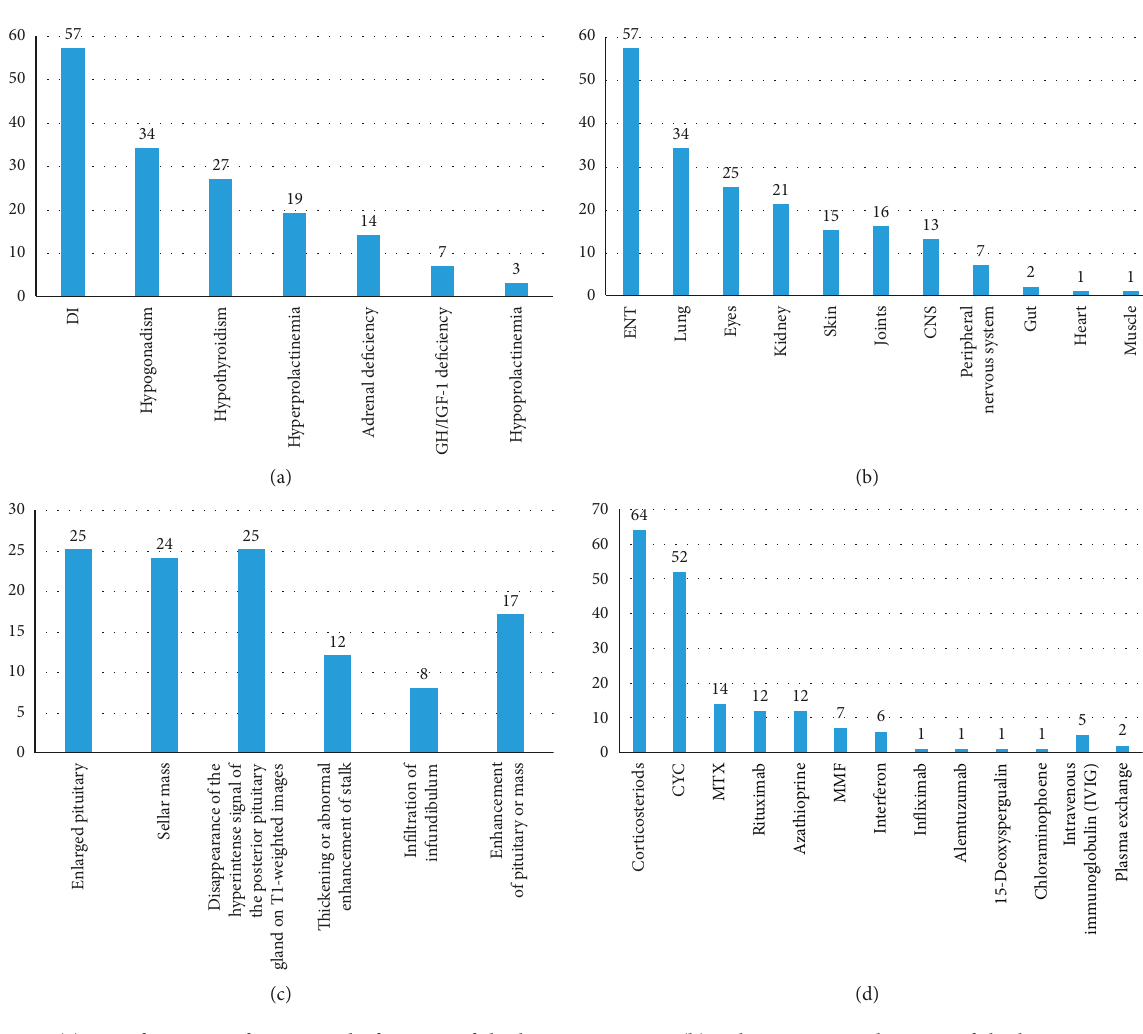
Figure 2: (a) Manifestations of pituitary dysfunction of the literature review. (b) Other organ involvement of the literature review. (c) Radiological abnormalities of the pituitary of the literature review. (d) Treatments of GPA of the literature